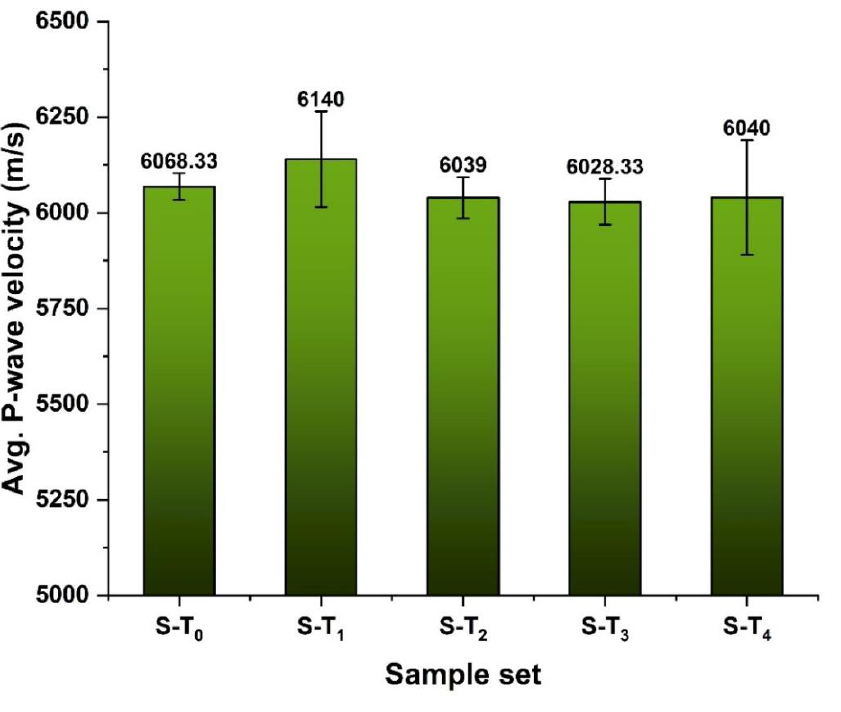
Figure 10. The P-wave velocity of the categorized set of specimens.